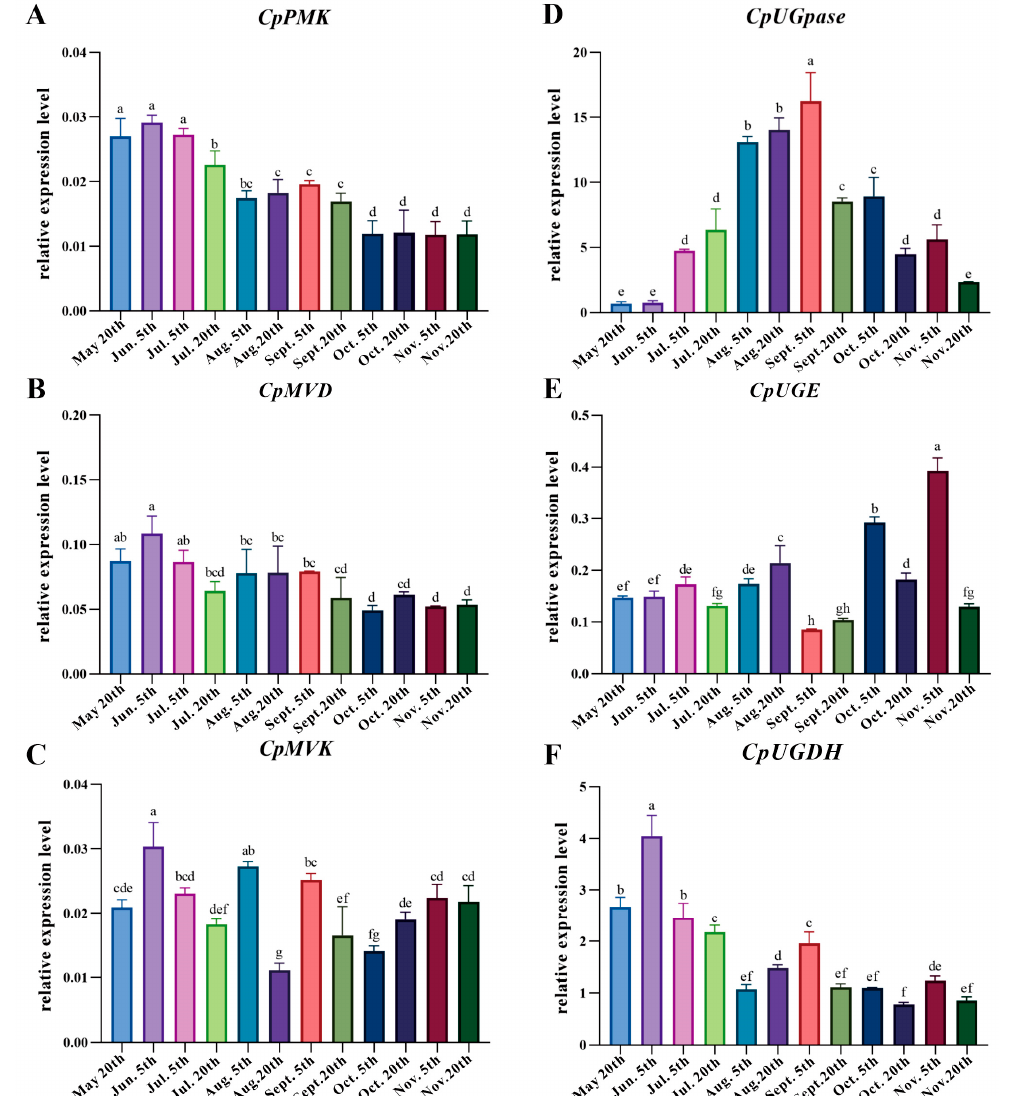
Figure 5. Expression patterns of the key enzyme genes involved in the terpenoid and carbohydrate biosynthetic pathways during the different growth stages determined by qRT-PCR. All data represent means ± SE ( n ≥ 3). Different letters above the bars indicate a significant difference ( p < 0.05) by one- way ANOVA with Tukey’s multiple comparison test. ( A ) The relative expression of CpPMK . ( B ) The relative expression of CpMVD . ( C ) The relative expression of CpMVK . ( D ) The relative expression of CpUGpase . ( E ) The relative expression of CpUGE . ( F ) The relative expression of CpUGDH